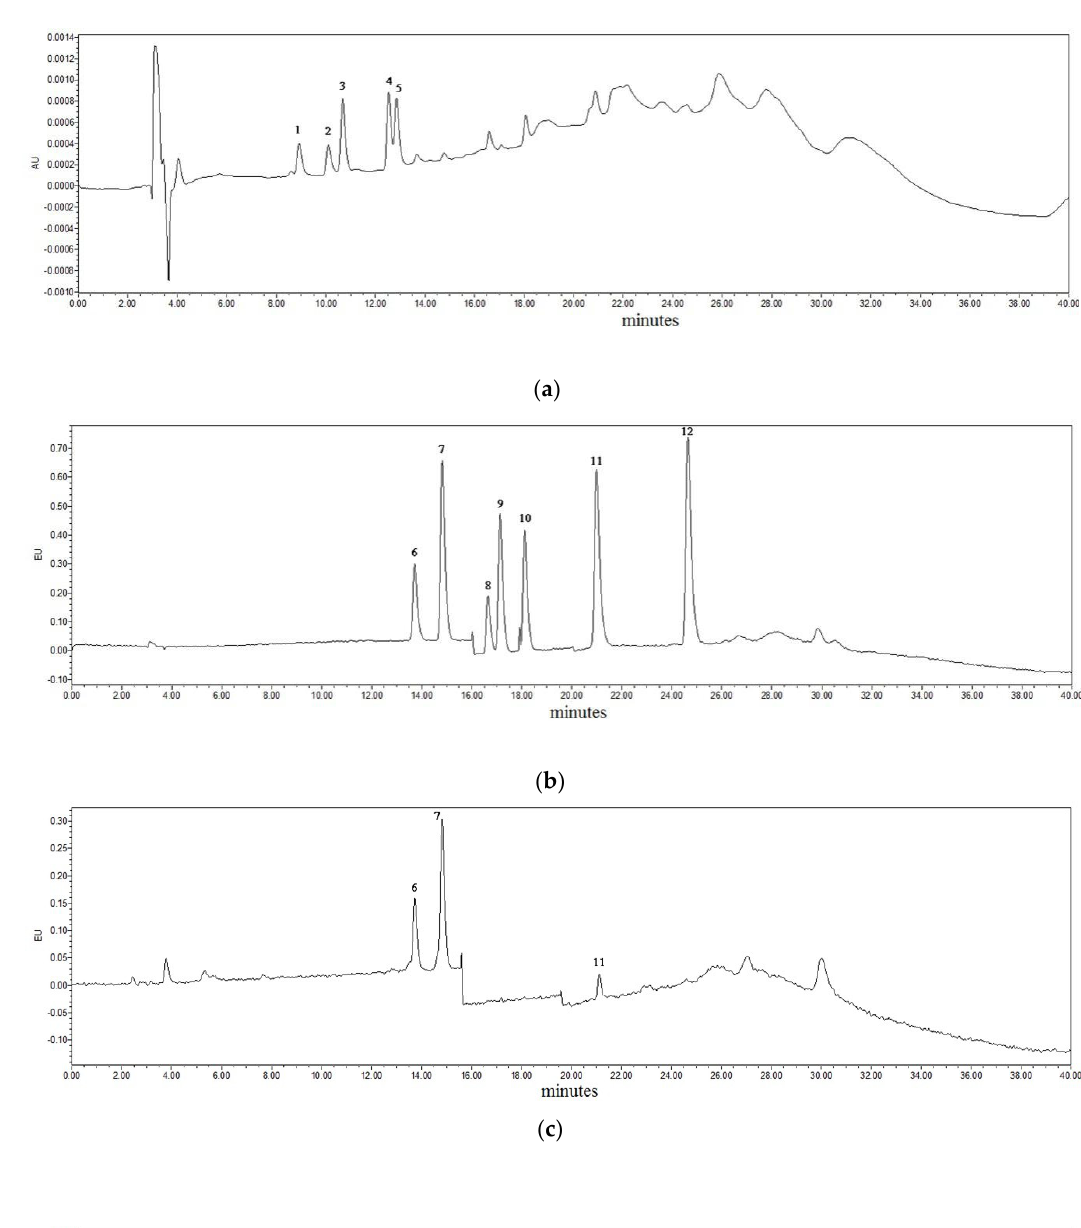
2335.7 ± 125.1 aA x Values were expressed as the means ± standard deviation, and values with different superscript letters in the same row were significantly different. For total COPs only: A-C denote values with different letters in the same column were significantly different). y ND = not detected. 3.2. Effects of Cooking Cycle Times of Marinating Juice on the Formatmion of Has in Marinated Pig Hock Skin, Subcutaneous Fat and Lean Meat The HPLC chromatograms of a mixture of HA standards and a representative sample are